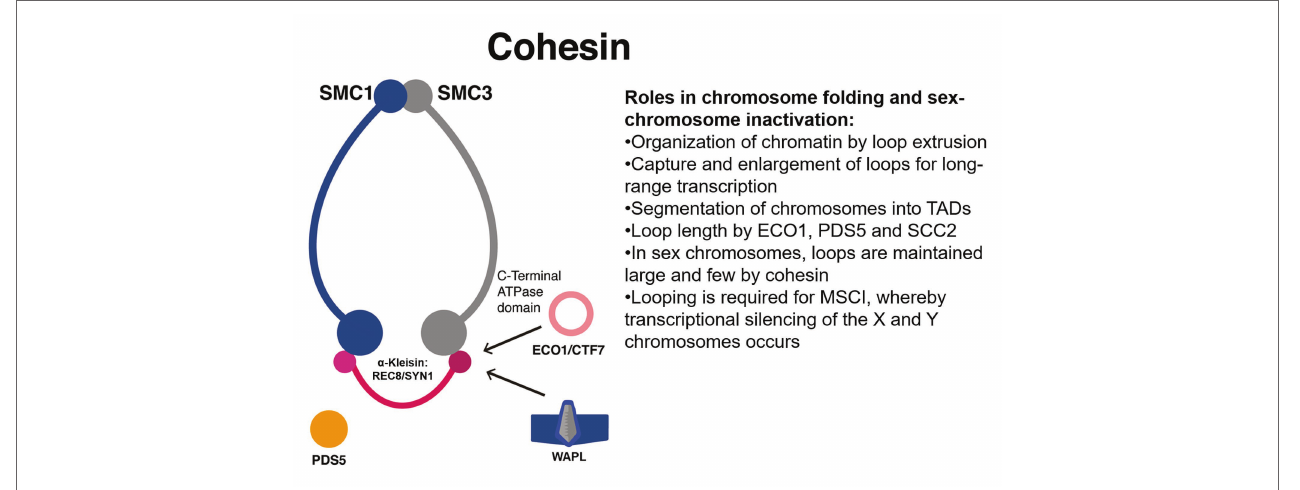
FIGURE 4 | Proposed roles for the SMC cohesin complexes in meiotic silencing of unsynapsed chromatin in sex chromosomes. Cohesin has roles in the organization of chromatin into loops that regulate expression and in sex chromosomes, may enforce silencing. ECO1/CTF7, N-terminal acetyltransferase ESTABLISHMENT OF COHESION 1/CHROMOSOME TRANSMISSSION FIDELITY 7; MSCI, meiotic sex chromosome inactivation; PDS5, HEAT-repeat protein PRECOCIOUS DISSOCIATION OF SISTERS; TADs, topologically associating domains; WAPL, cohesin dissociation factor WINGS APART